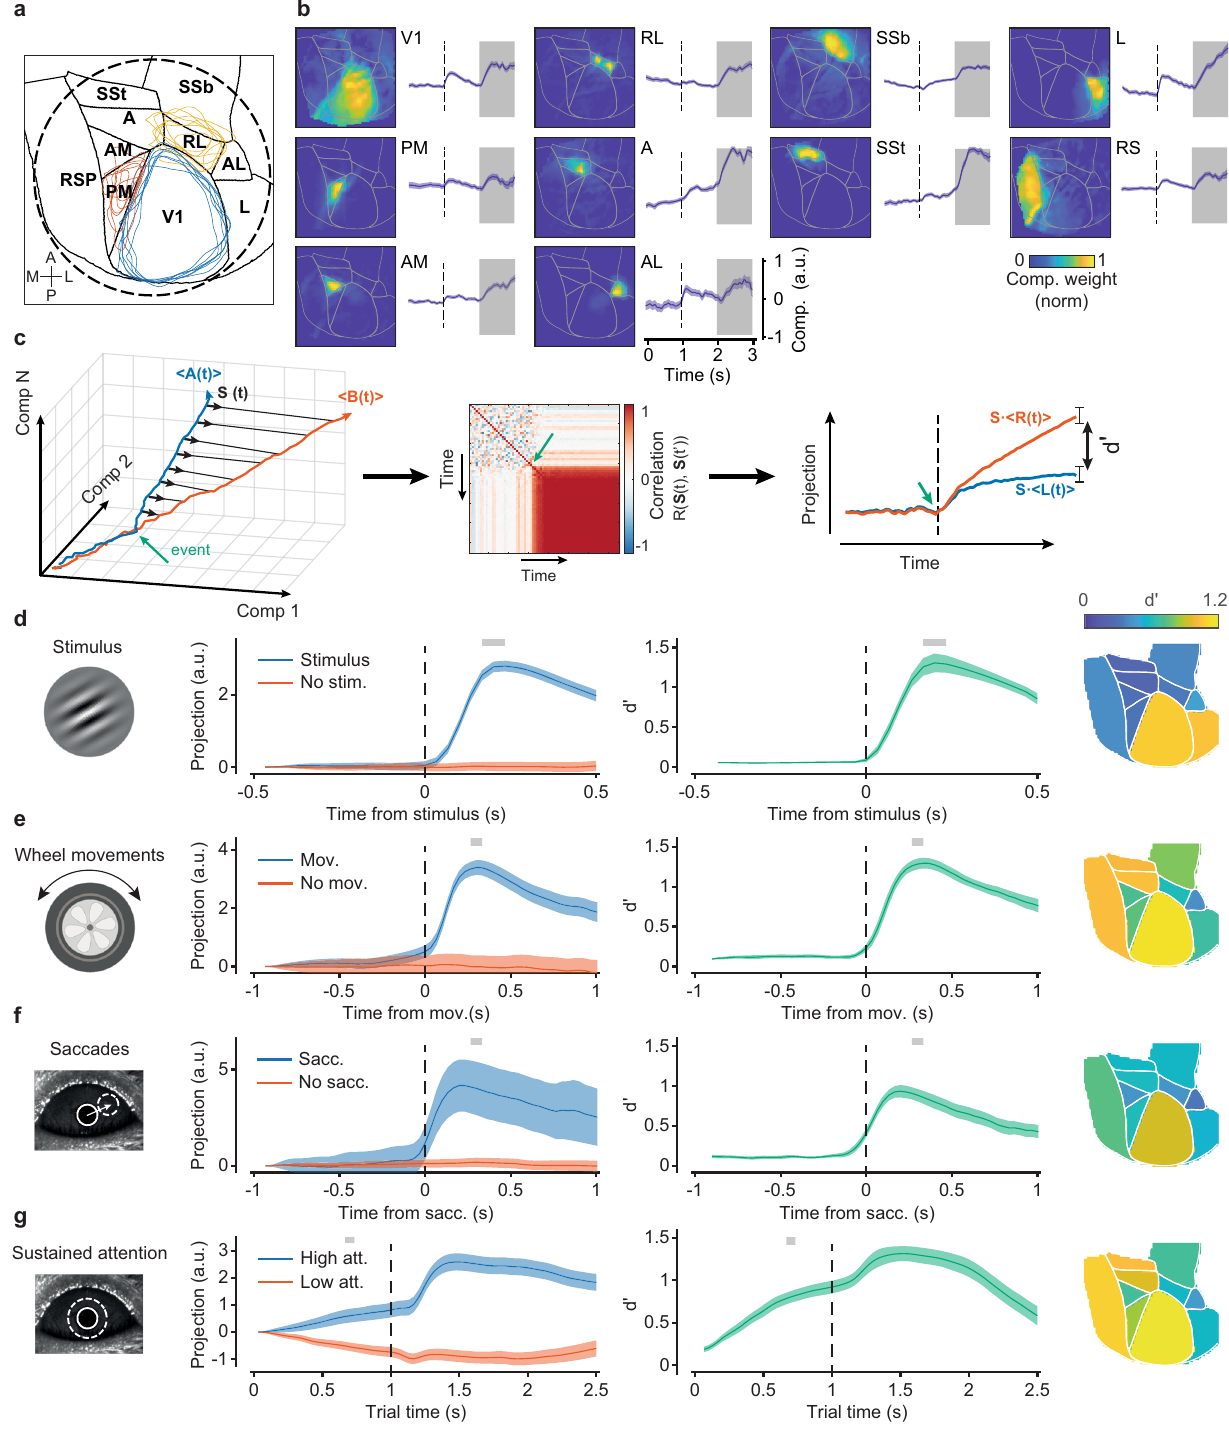
AllenCommon Coordinate Framework 39 (Fig.2a)and seededtheinitial spatial decomposition using 10 large regions centered on retinotopi- cally identi fi ed areas (based on fi eld sign maps, Supplementary Fig. 1a, see also ref. 20 ) that extended signi fi cantly beyond area boundaries (Supplementary Fig. 1b). Consistent with the initial seeding, the fac- torization typically converged toward components with peak ampli- tudes within individual retinotopic areas (Fig. 2b, see Supplementary